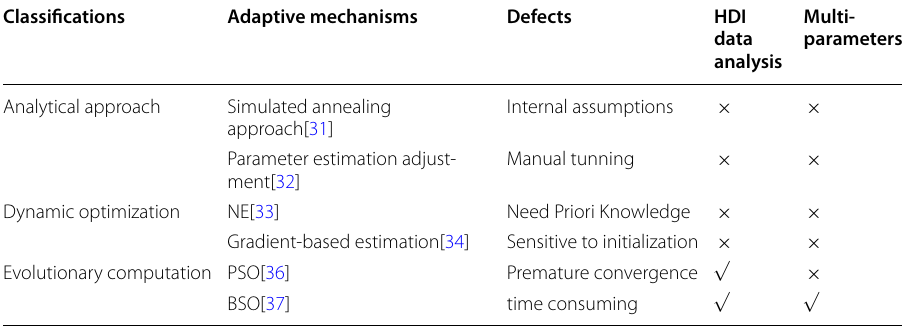
ADMA employs evolutionary computation DE as the multi‑parameter adaptive mechanism and improve its optimization progress by an annealing technique. Therefore, ADMA inherits the flexibility and adaptively of swarm intelligence, while enjoying the exploration and exploitation merits of the improved DE, which thereby can solve the big data analysis problems well especially conducting an LFA on an HDI matrix